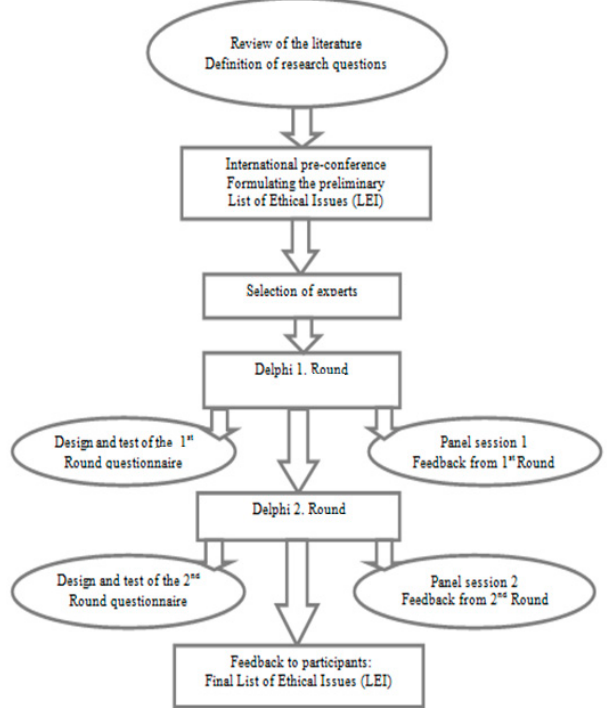
Figure 2. On-line Delphi process (adapted).